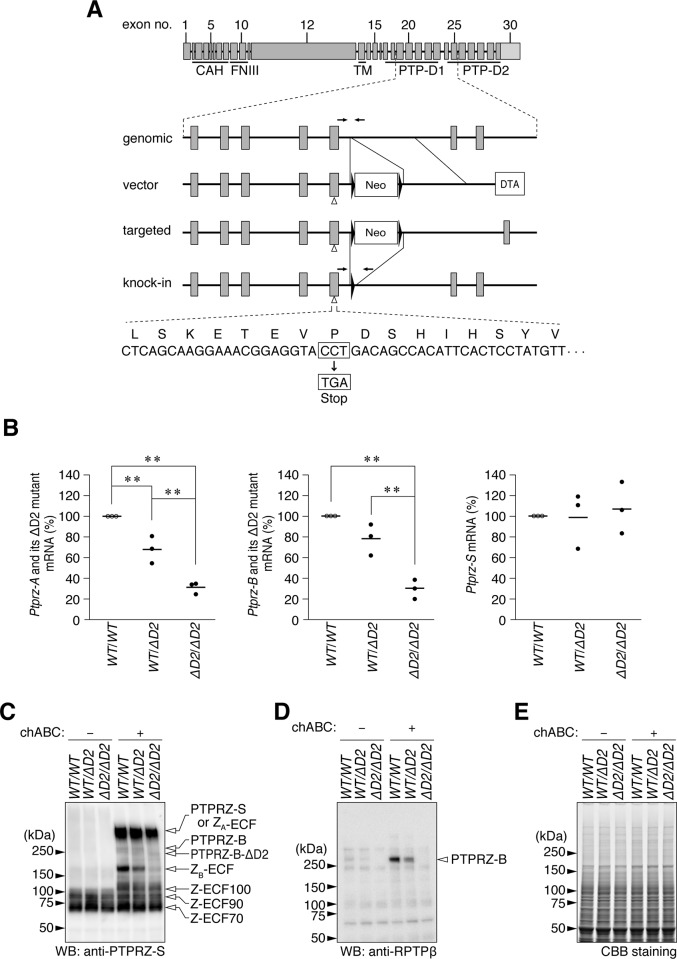
Ptprz-ΔD2 knock-in mouse.(A) Strategy to generate a Pro-1998 to termination (ΔD2) knock-in in the Ptprz gene. Schematic representation of the exon/intron structure of the Ptprz gene. Each box indicates an exon with the exon number, and the final exon 30 containing the 3'-non-coding sequence (light gray). Horizontal arrows indicate PCR primer sites for mouse genotyping. CAH, carbonic anhydrase-like domain; FNIII, fibronectin type III domain; TM, transmembrane region; PTP-D1 and -D2, tyrosine phosphatase domain 1 and 2. Neo, neomycin-resistance gene cassette; DTA, diphteria toxin A gene cassette. Filled triangles show loxP sites. (B) Quantitative RT-PCR. The mRNA expression levels of Ptprz-A and Ptprz-B (total of both wild-type and ΔD2 mutant forms) and Ptprz-S in adult brain tissues were measured using the respective primer sets shown in S1 Fig. They were normalized to Gapdh expression, and plotted as relative values to wt/wt mice (n = 3 individual mice per group). wt/wt, homozygous for the wild-type allele; wt/ΔD2, heterozygous; and ΔD2/ΔD2, homozygous for the ΔD2 mutant allele. There were significant effects of genotype on the expression levels of Ptprz-A (F(2, 6) = 55.663, P = 0.000) and Ptprz-B (F(2, 6) = 37.680, P = 0.000), but not Ptprz-S (F(2, 6) = 0.006, P = 0.874) by a univariate analysis of variance (UNIANOVA). **, P < 0.01, significant difference between the indicated groups by Tukey’s post-hoc HSD test. (C, D) Western blot analyses of brain extracts treated with (+) or without (-) chondroitinase ABC (chABC). In brain tissues, PTPRZ-A, -B, and -S and their processed derivatives (ZA-ECF and ZB-ECF) were highly modified with chondroitin sulfate chains, and, therefore, the chABC treatment beforehand was necessary for resolving their core proteins by SDS-PAGE [17, 30]. Anti-PTPRZ-S (C) and anti-RPTPß (D) recognize the extracellular region of all three PTPRZ isoforms, and the epitope on the C-terminal part of the PTP-D2 domain, respectively [17]. (E) CBB staining of samples to verify their protein amounts applied to each lane.